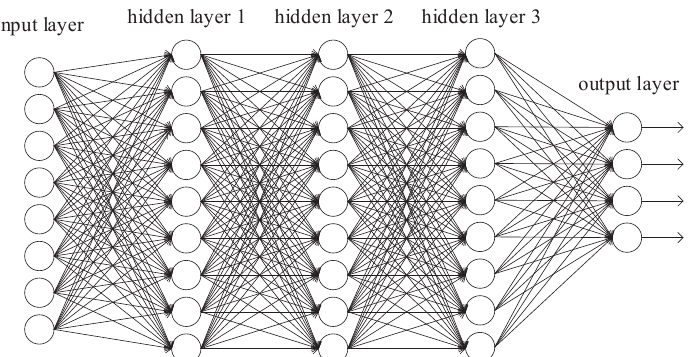
Figure 11. Deep neural networks